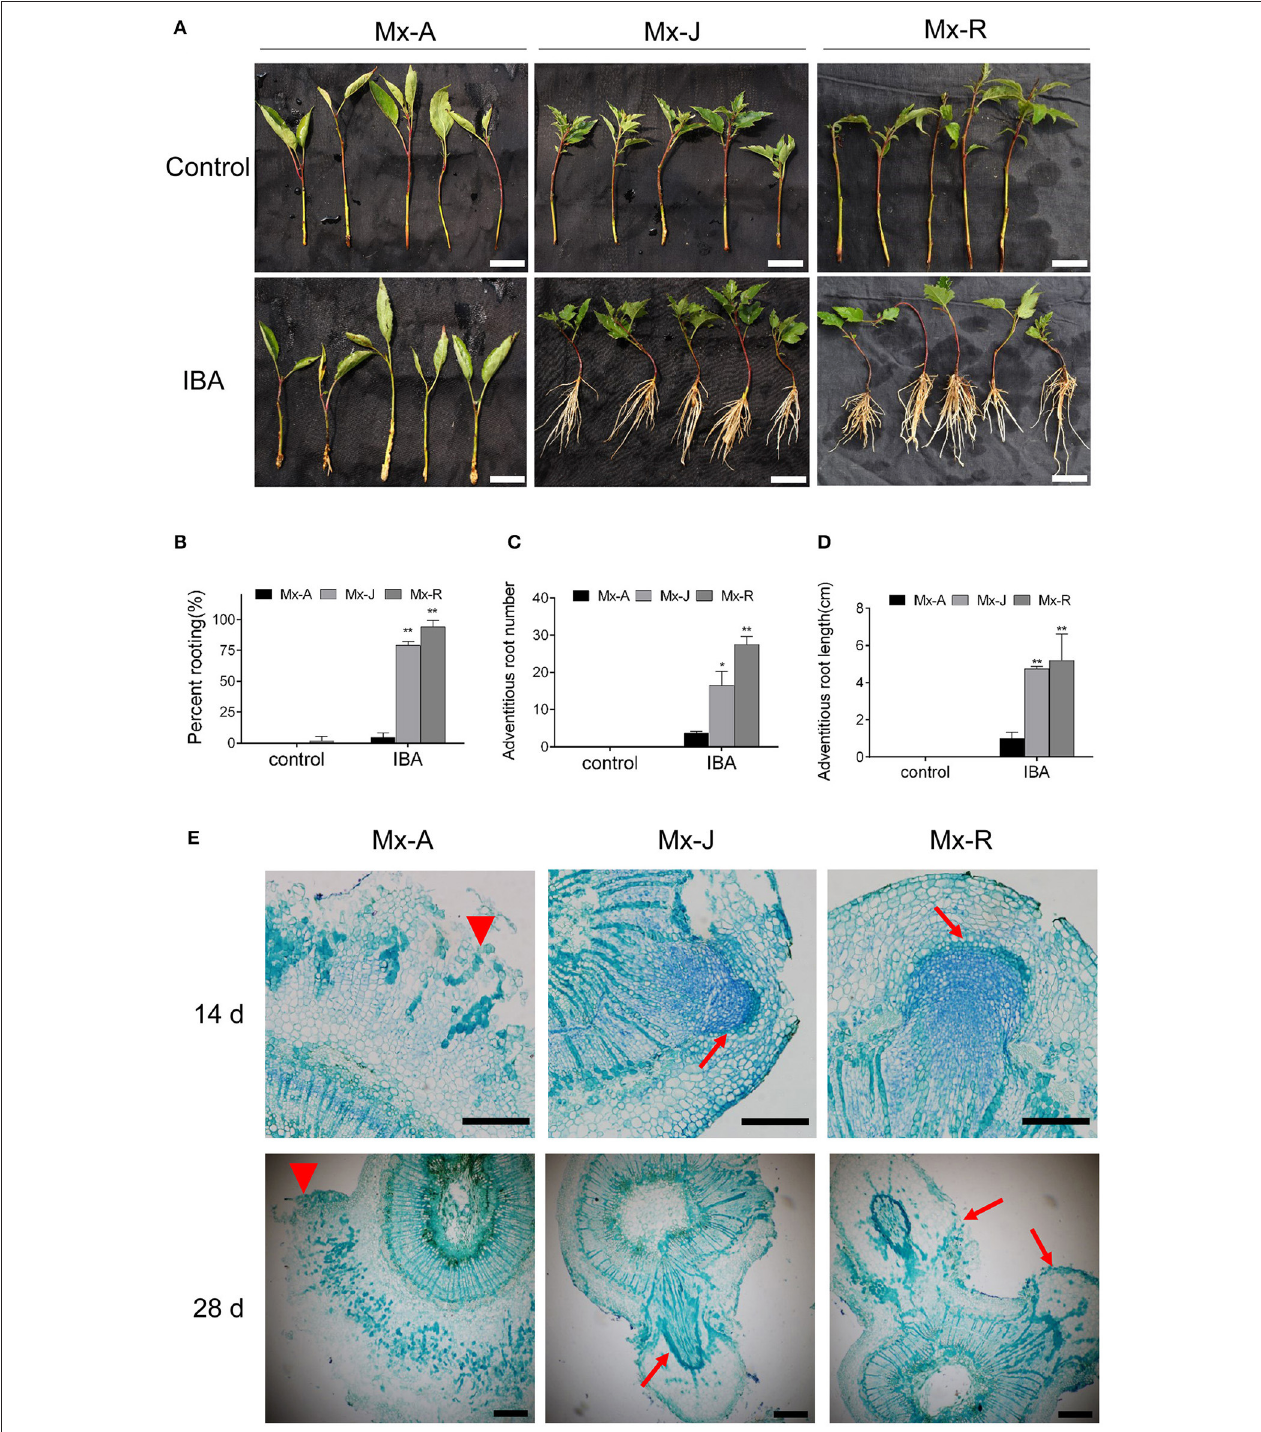
FIGURE 1 | Adventitious rooting ability of adult phase (Mx-A), juvenile phase (Mx-J) and rejuvenated (Mx-R) leafy cuttings of Malus xiaojinensis . (A) Morphological features, (B) rooting percent, (C) adventitious root number, and (D) adventitious root length of Mx-A, Mx-J, and Mx-R cuttings at 35 d of IBA or control treatments. Scale bars = 20 mm in (A) . (B–D) Bars show SD from three biological replicates. n = 50 individuals in each replicate. Asterisks indicate significant difference from the Mx-A (Student’s t -test, ** P < 0.01, * P < 0.05). (E) Histological features of Mx-A, Mx-J, and Mx-R cuttings during adventitious root formation at 14 days (upper) and 28 days (bottom) after IBA treatment. Toluidine Blue-stained cross section of the stem of Mx-A, Mx-J, and Mx-R at 14 and 28 days after IBA treatment. Arrows indicate emerging adventitious root initials. Scale bars = 200 µ m in (E) .